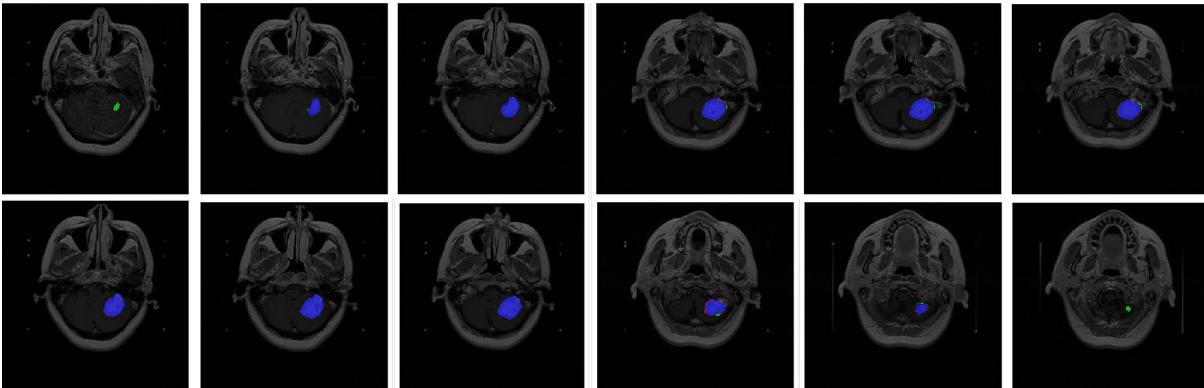
Figure 7. Visualization the segmentation by the ensemble